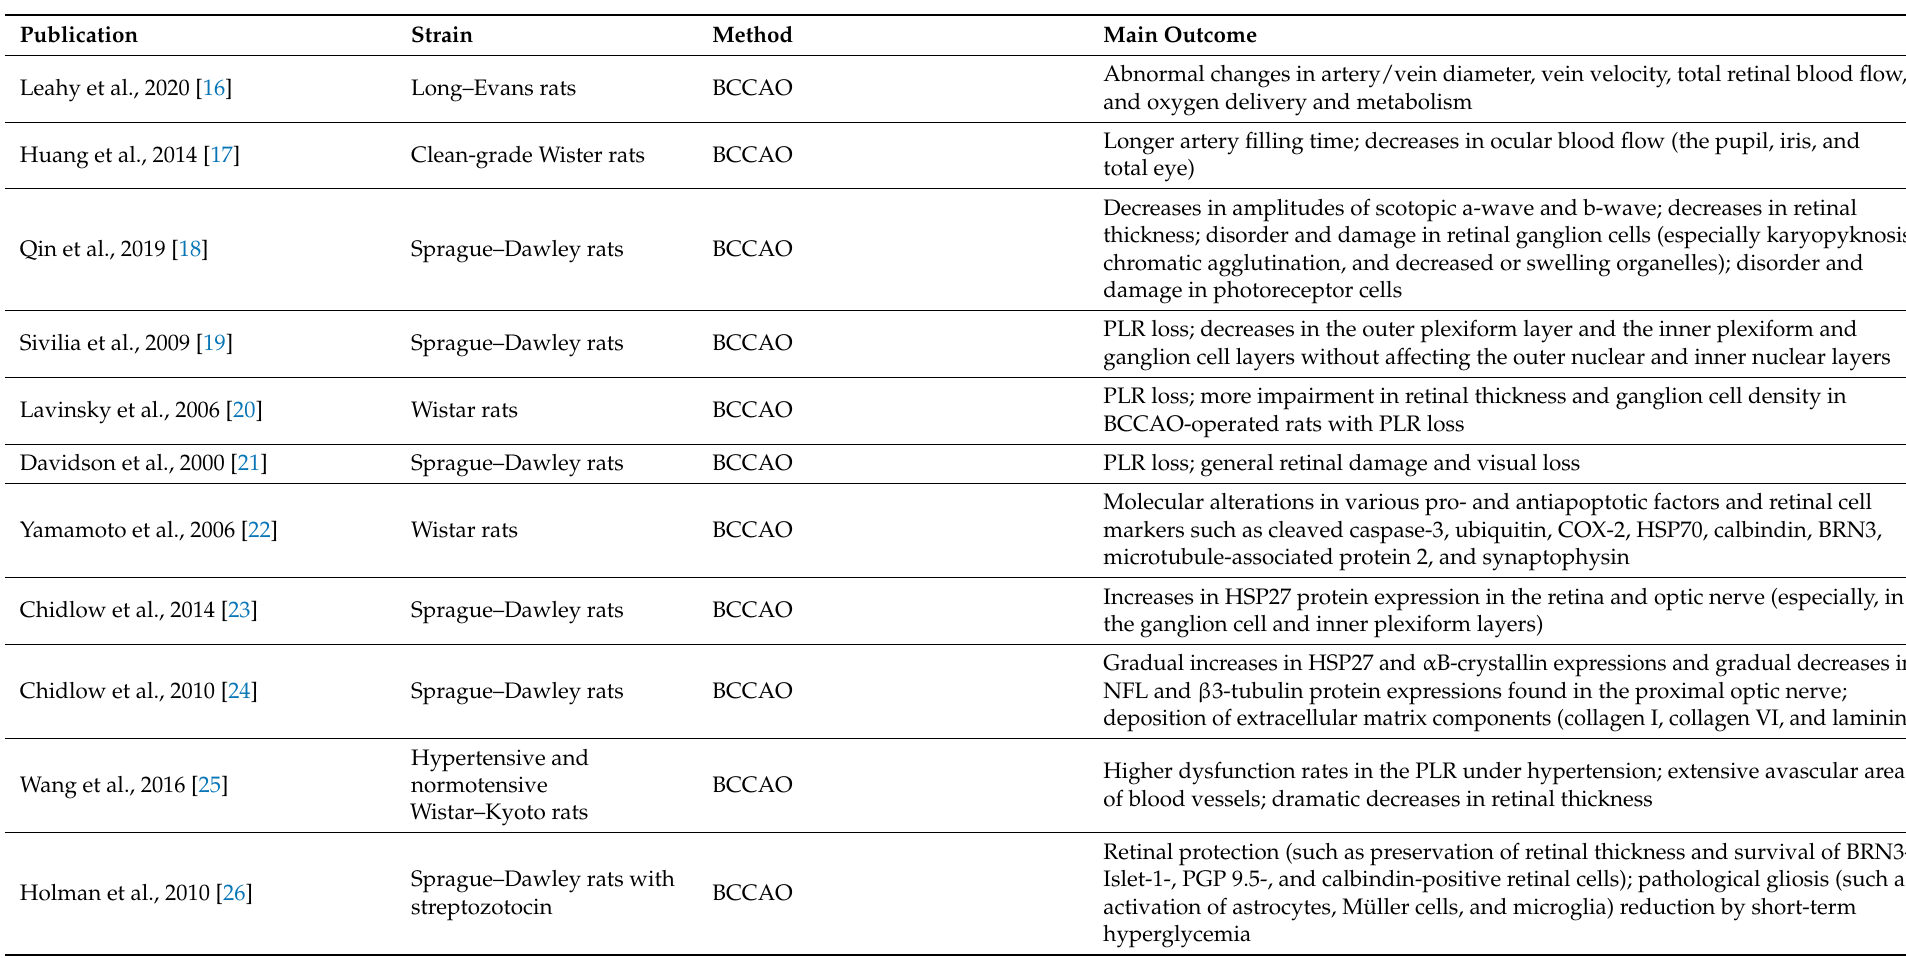
Table 1. Summary of experimental models of